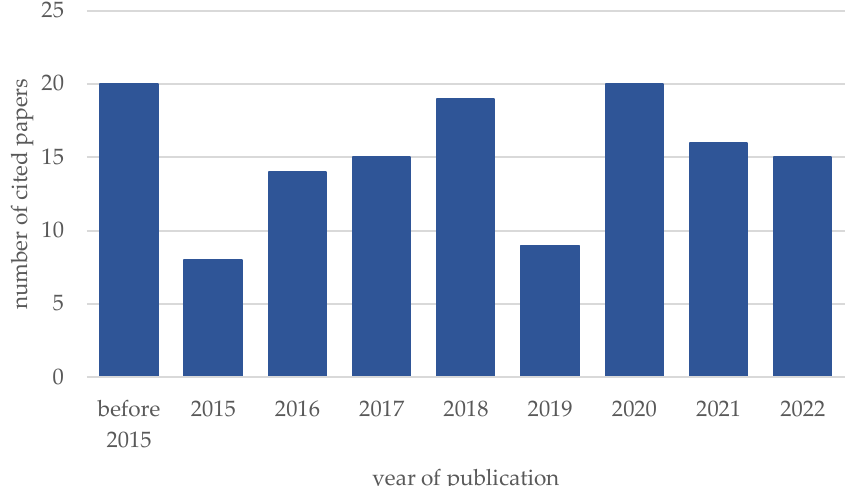
Figure 2. Year of publication of the reviewed articles.